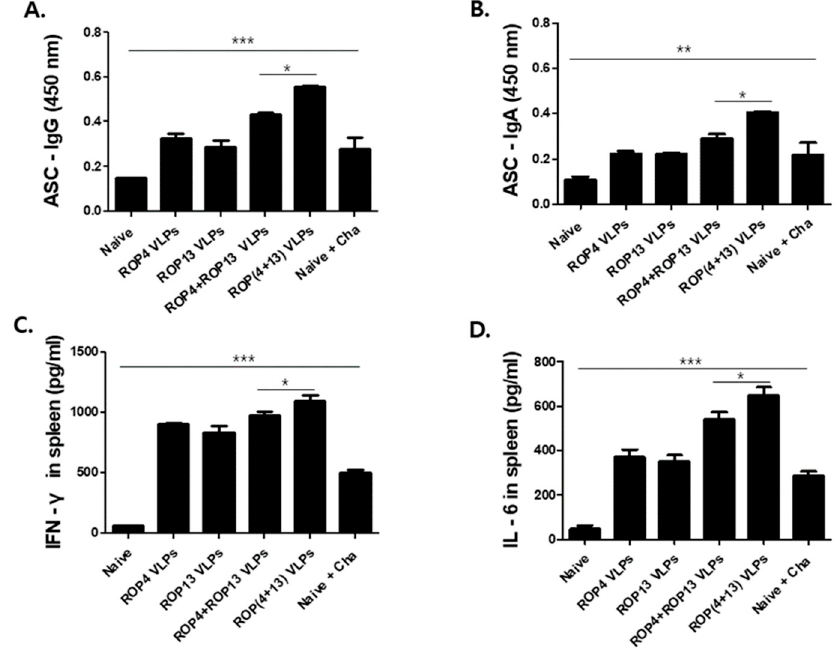
Figure 4. Cytokine production and antibody secreting cell responses (ASC). Immunized mice ( n = 5) were challenge-infected orally with 450 T. gondii ME49 cyst at week 4 after boost immunization. After 4 weeks, isolated splenocytes were collected from infected mice and cells were incubated for 3 days with T. gondii RH. T. gondii VLP is e ff ective in inducing antibody secreting cell responses and cytokines. IgG antibody secreting cells in spleen (( A ), * p < 0.05, *** p < 0.001). IgA antibody secreting cells in spleen (( B ), * p < 0.05, ** p < 0.01). Cytokine levels of IFN- γ (( C ), * p < 0.05, *** p < 0.001) and IL-6 (( D ), * p